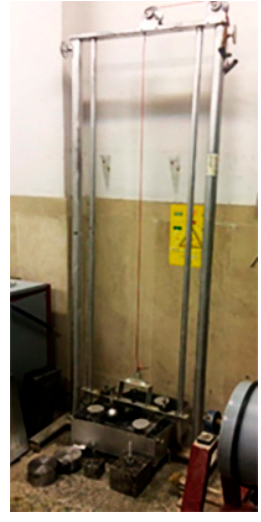
Figure 6. The drop weight device.